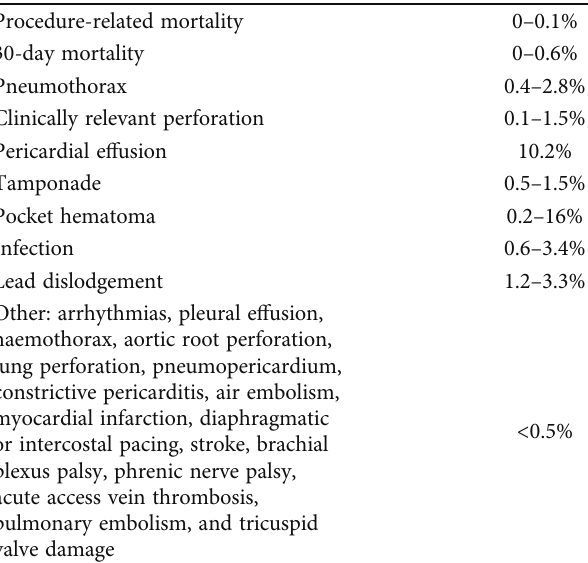
Figure 5: ECG after resynchronization. Table 1: Device-related